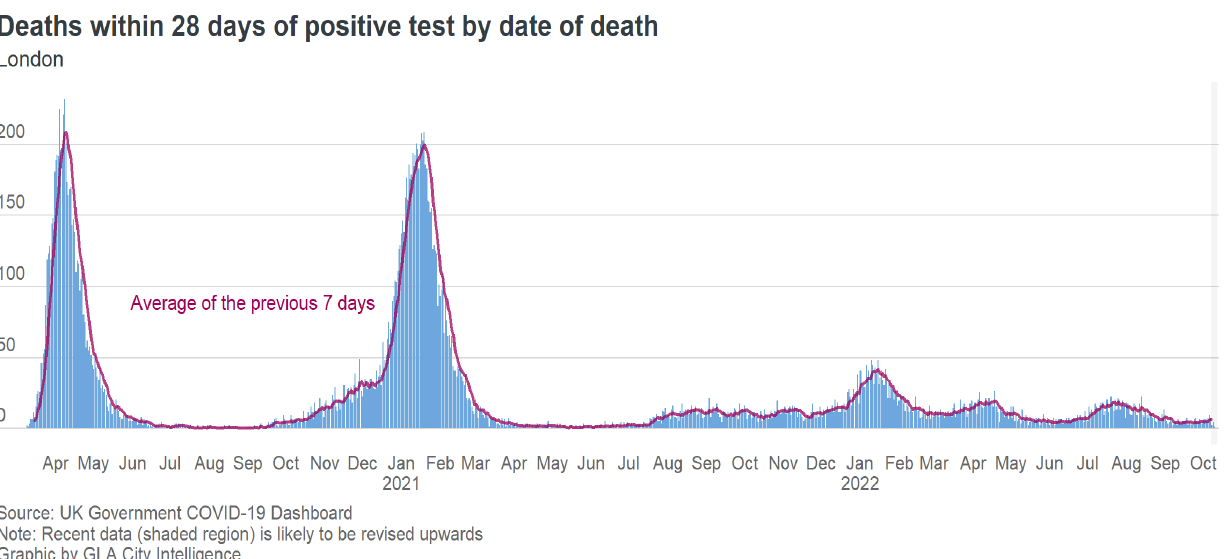
Figure 10. COVID-19 deaths in London since outbreak onset. Source: UK Government COVID-19 Dashboard. https://data.london.gov.uk/dataset/coronavirus--covid-19--cases, assessed on 15 October 2022.